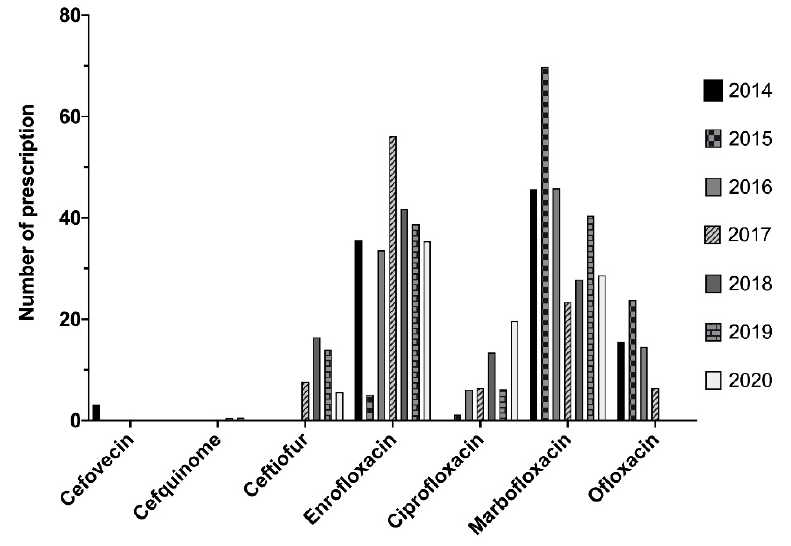
Figure 4. Distribution of CIAs during 2014 through 2020 regardless of species and route of administration.